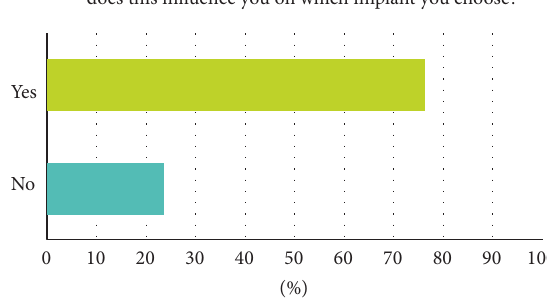
Figure 1: Example question taken from the survey, answers in